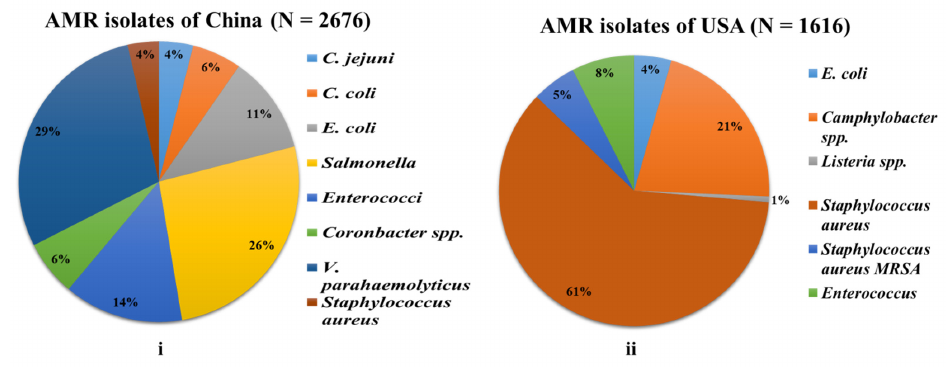
Figure 5. Individual AMR isolates with their respective percentages: ( i ) China; ( ii ) USA.